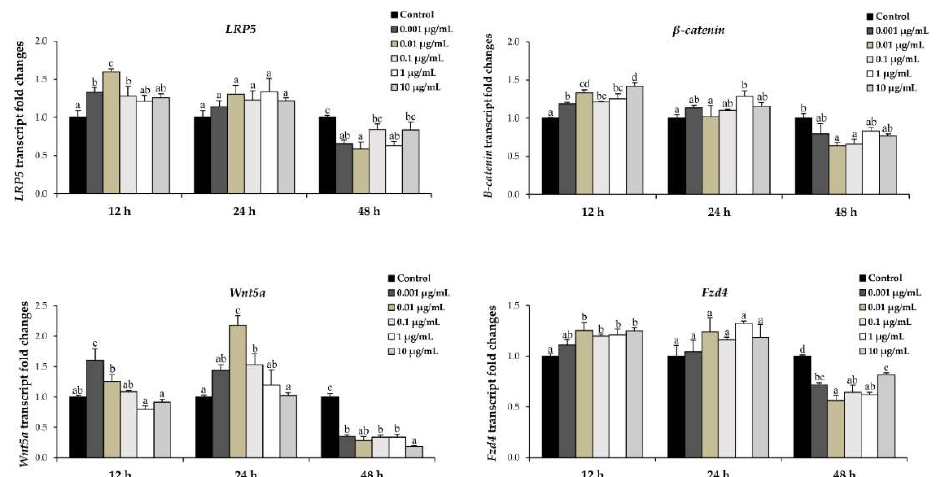
Figure 7. Quantitative real-time PCR was used to analyze the expression of Wnt/β-catenin signaling pathway genes LRP5 , β-catenin , Wnt5a , and Fzd4 in osteoblast cells cultured with various concentrations of L -quebrachitol for 24, 48, and 72 h. A representative example of 3 independent experiments. Each data point represents the means of 4 replicate samples ± SEM. The data in columns with different letters in each group were significantly different at p < 0.05.